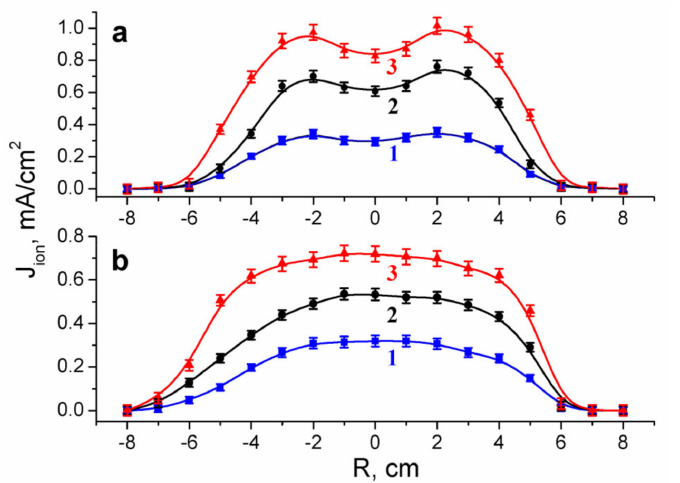
Figure 6. Radial distribution of ion beam current density. Distance between ion source and probe: ( a ) 30 cm, and ( b ) 55 cm. 1 —magnetron current 6 A, 2 —10 A, 3 —17 A. Copper magnetron target, Copper vacuum arc cathode. Ion source output diameter 6.6